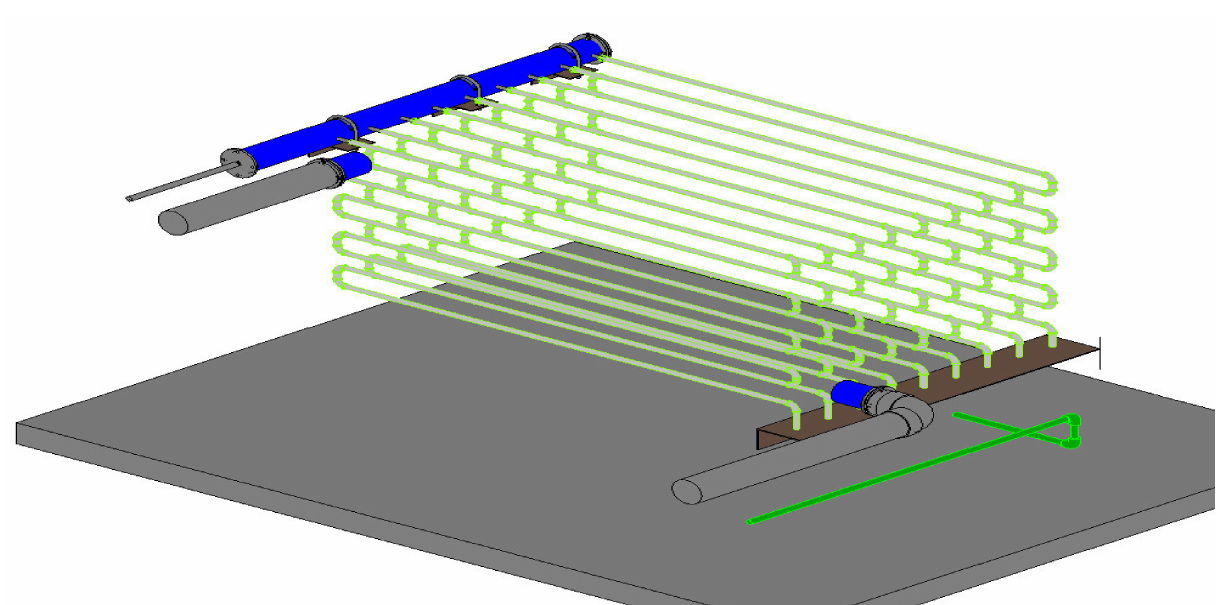
Figure 2. Design diagram of heat exchanger inside cold storage